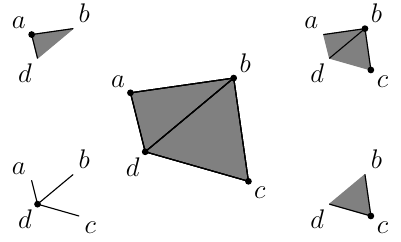
Figure 3. Distributed data structure representing the simplicial complex shown in the